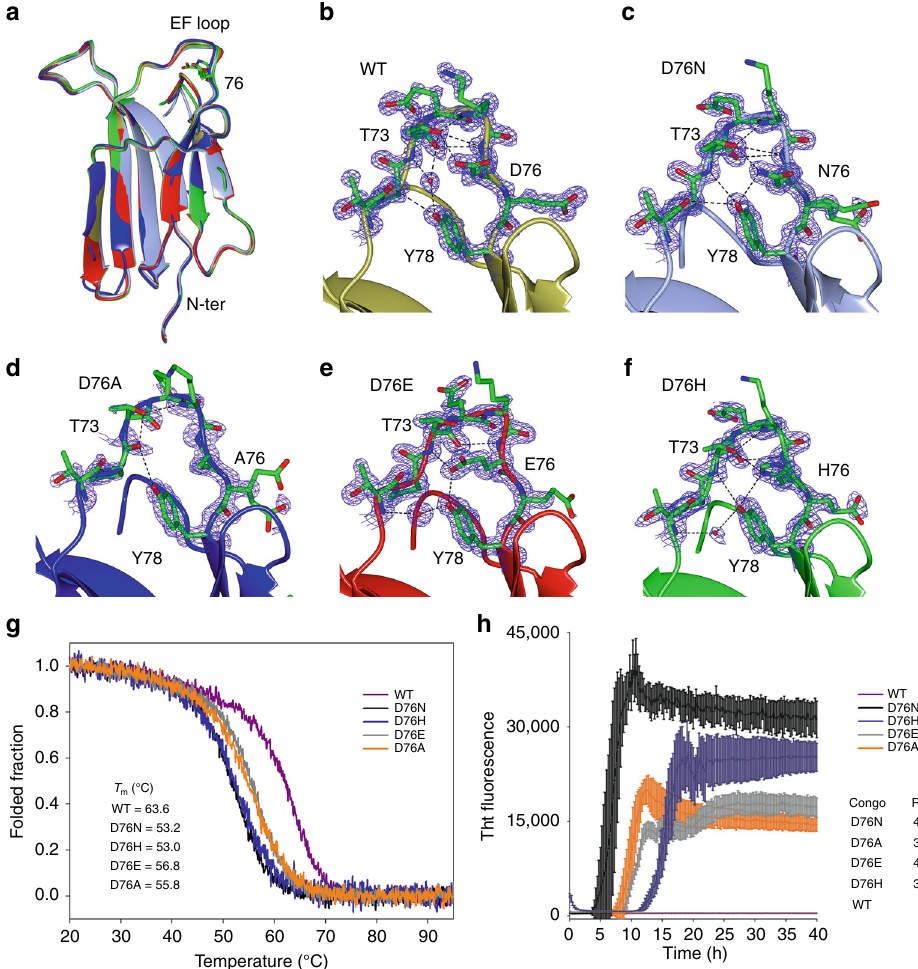
Fig. 1 Structural and biophysical characterization of β 2m mutants at position 76. a Superposition of the structures of wt β 2m (2YXF, gold) and of the D76N (4FXL, light blue), D76A (blue), D76E (red), and D76H (green) variants. The residues in position 76 are modeled as cylinders. b – f Zoom-in of the EF loop of the structures shown in a . H-bonds are displayed as dash lines and electron density ( σ = 1.2) is clipped around the EF loop. g Normalized temperature ramps monitored by far-UV circular dichroism at 202nm for wt β 2m and of all four 76 mutants. h Aggregation kinetics monitored by thio fl avin T fl uorescence and a Congo Red evaluation of the resulting aggregates (number are indicating the fl uorescence intensity on a qualitative